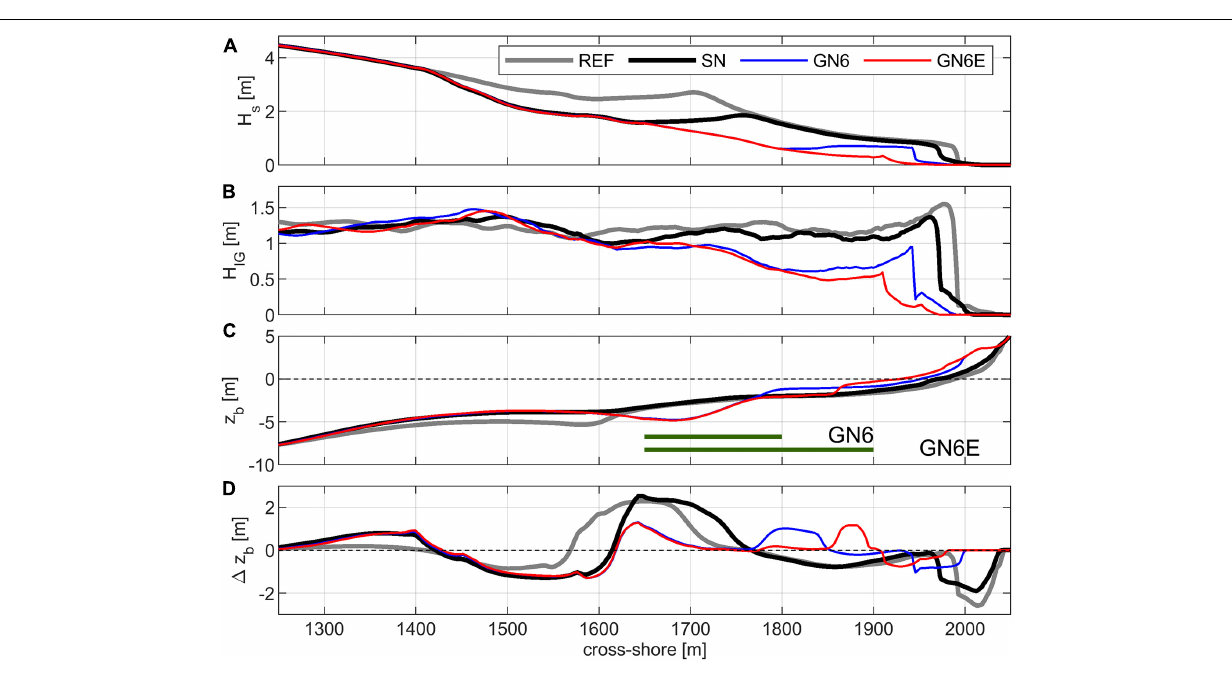
survival rate to the GN6 case. However, the storm event caused almost the entire seagrass meadow to be buried in the GREF case, except at the seaward edge where erosion was observed ( Figure 15E ). Whilst sediment deposition rates were high at the